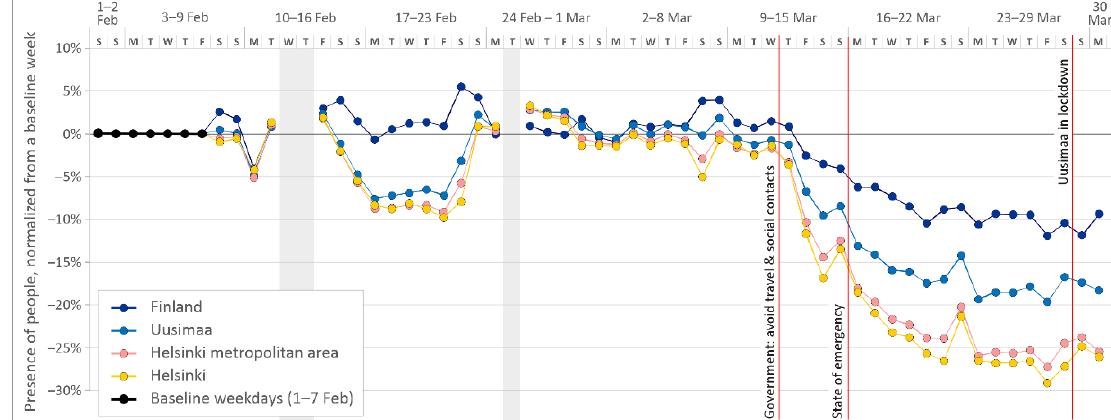
Figure 2. The varying presence of people at the municipality level compared to the baseline weekdays (1–7 February) in Helsinki, Helsinki metropolitan area (four municipalities), Uusimaa (26 municipalities), and in Finland (311 municipalities).